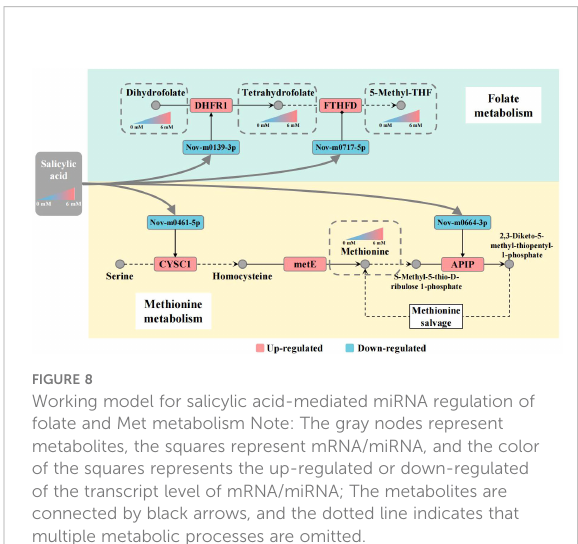
FIGURE 8 Working model for salicylic acid-mediated miRNA regulation of folate and Met metabolism Note: The gray nodes represent metabolites, the squares represent mRNA/miRNA, and the color of the squares represents the up-regulated or down-regulated of the transcript level of mRNA/miRNA; The metabolites are connected by black arrows, and the dotted line indicates that multiple metabolic processes are